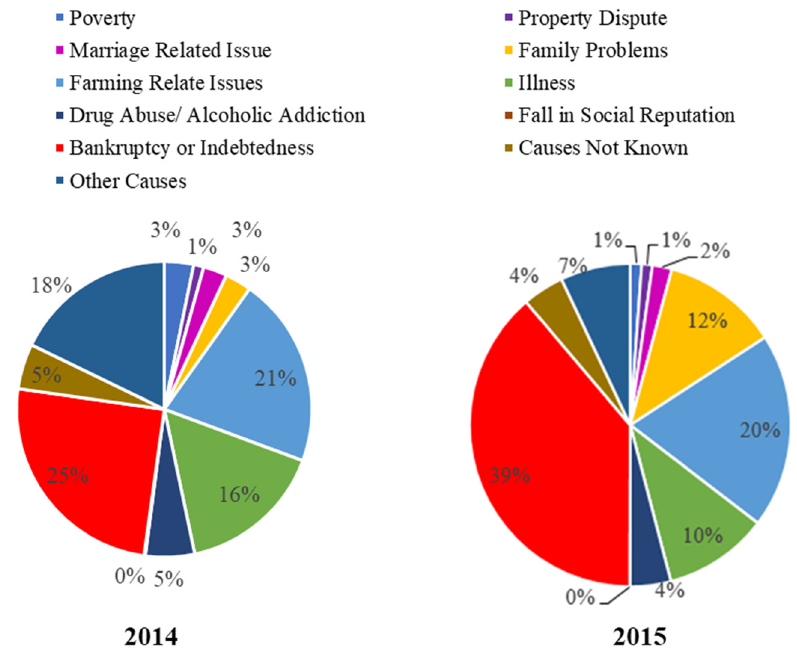
Figure 6. Causes of farmers’ suicide identified by NCRB in the year 2014 and 2015.